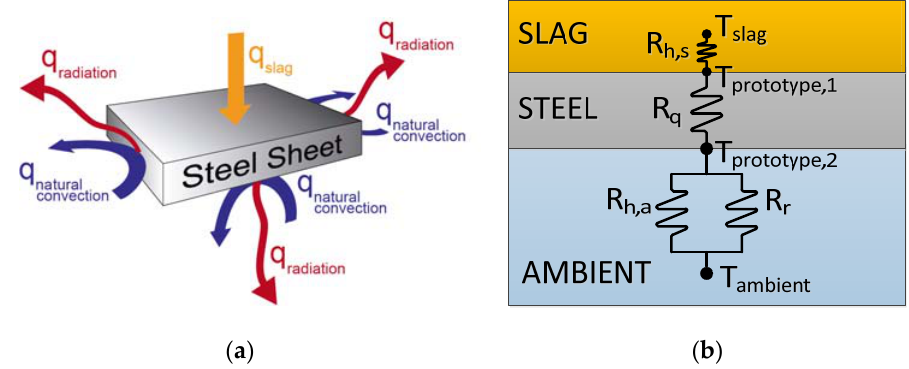
Figure 5. ( a ) Heat transfer mechanisms on port plates; ( b ) electrical analogy circuit.